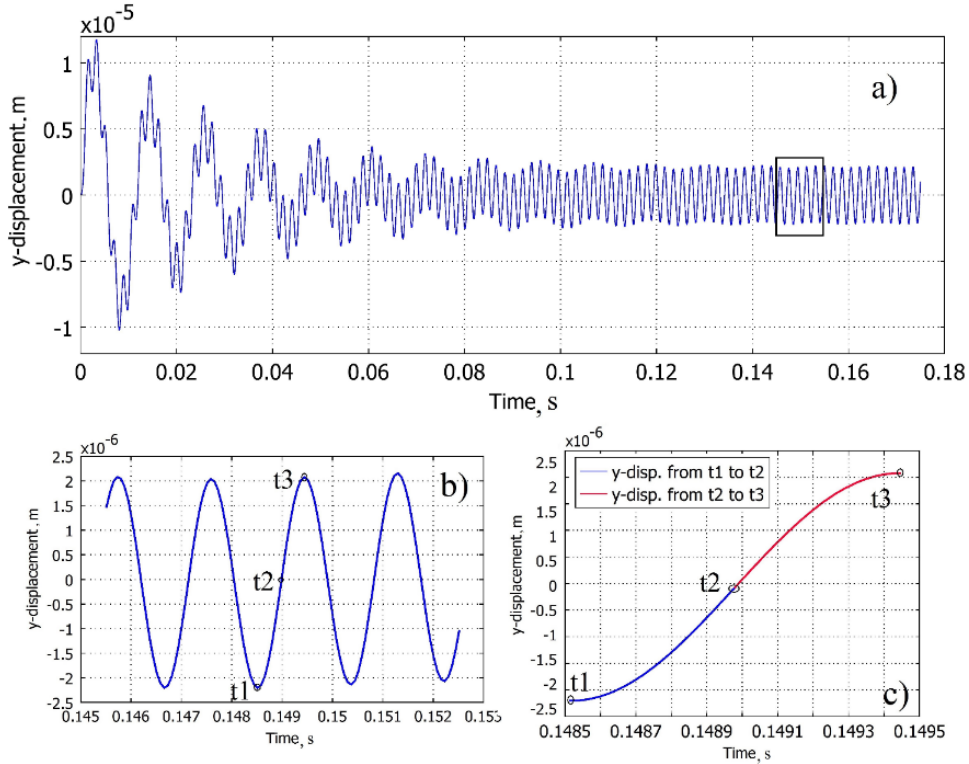
Figure 5. Cantilever free end displacement in the transverse direction: ( a ) dynamical process; ( b ) region of steady-state vibrations; ( c ) ½ T period of vibration for the analysis of the position of the cantilever strain nodal point.